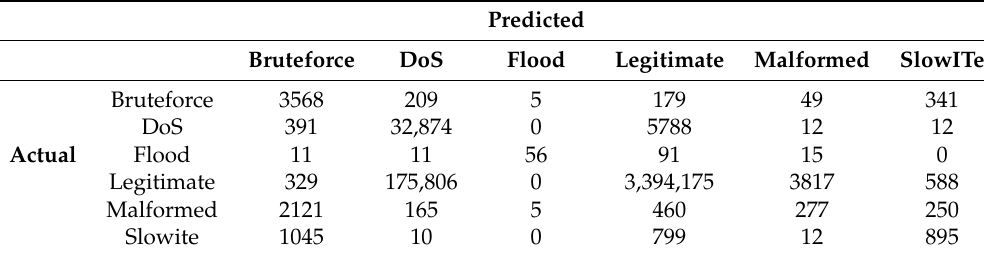
Table 11. Confusion matrix multilayer